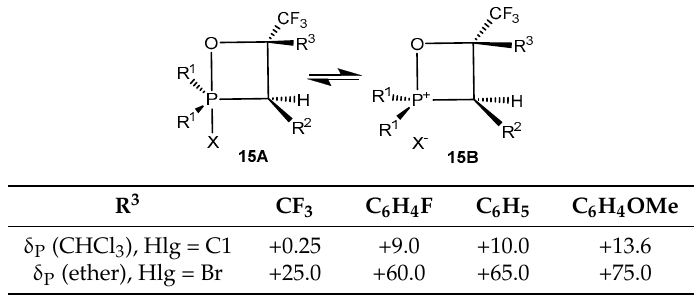
Table 4. Effect of solvent on δ P of 2-chloro and 2-bromo-1,2 λ 5 -oxaphosphetanes.